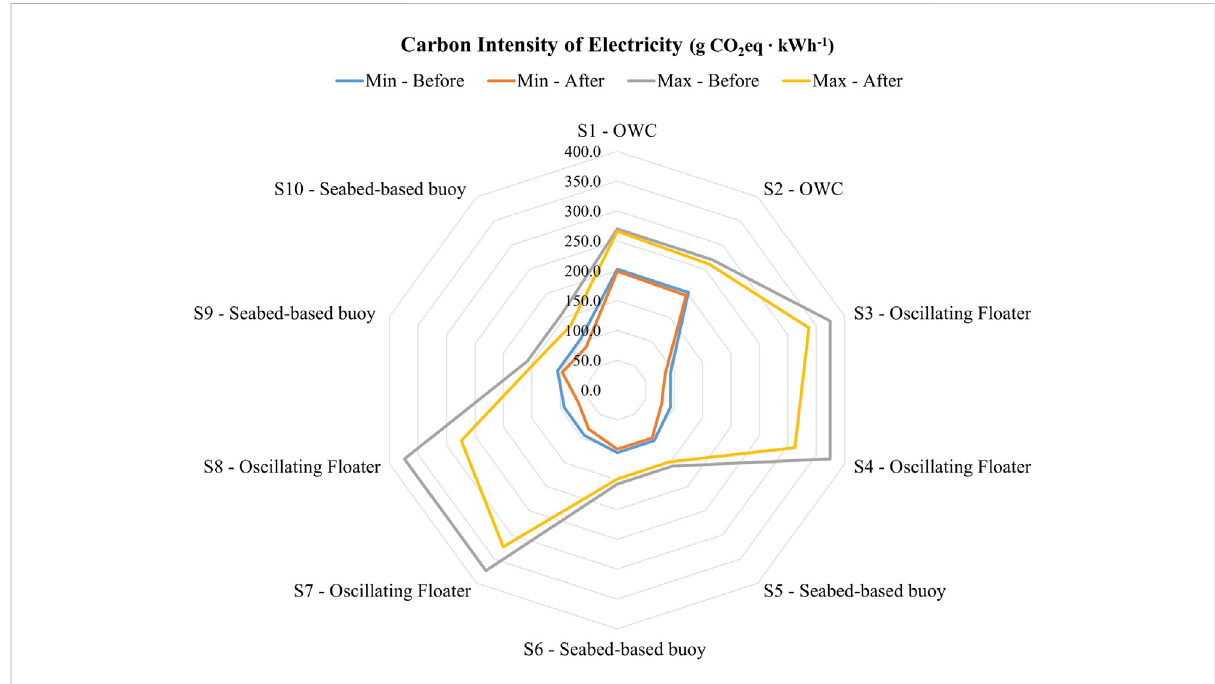
FIGURE 7 Results of the sensitivity analysis for each scenario